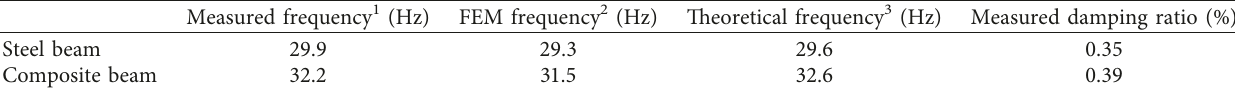
Figure 10: Measured acceleration curves and frequency spectrums of composite beam after assembly. (a) Acceleration time-history curves. (b) Acceleration frequency spectrums. Table 1: Comparison of results of vertical bending natural frequency and damping